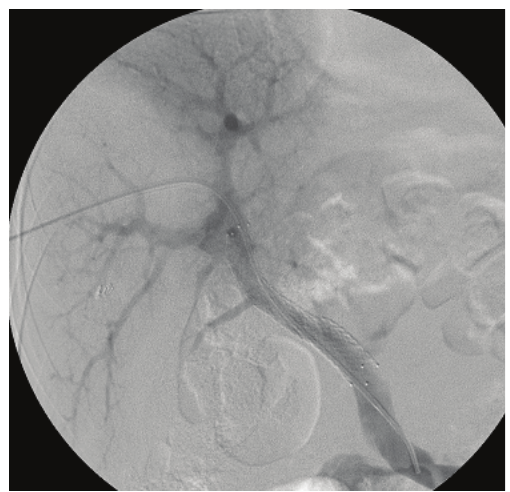
Figure 3: Poststenting portography showed portal venous patency and inflow had recovered completely with the gastroesophageal varices almost